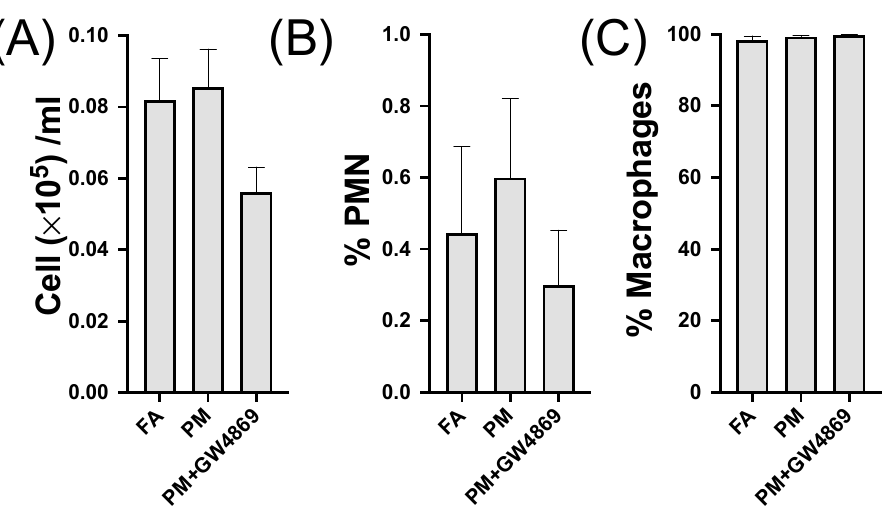
Figure 2. Bronchoalveolar lavage fluid. Cells from lung fluid from FA, PM, and PM + GW4869 inhibitor including ( A ) total cells, ( B ) polymorphonuclear neutrophils (% PMN), and ( C ) macrophages (% macrophages). A one-way ANOVA was performed with a Kruskal–Wallis post hoc test, and p ≤ 0.05 was considered significant. Data represent the mean ± SEM.